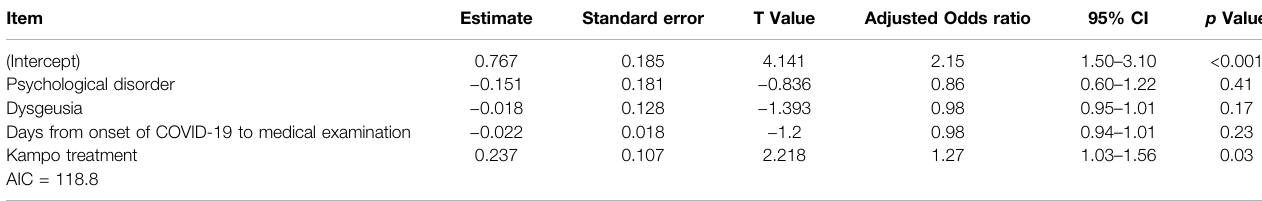
TABLE 3 | Multiple logistic regression analysis of variables affecting the improvement of olfactory dysfunction at one week after the fi rst visit. Item